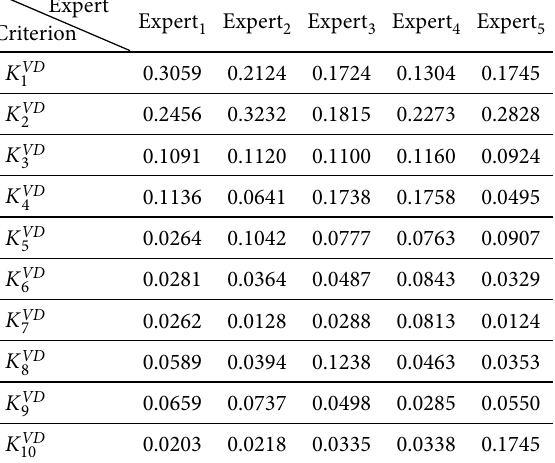
Table 6. Matrix of criteria weights assigned by experts Expert Criterion